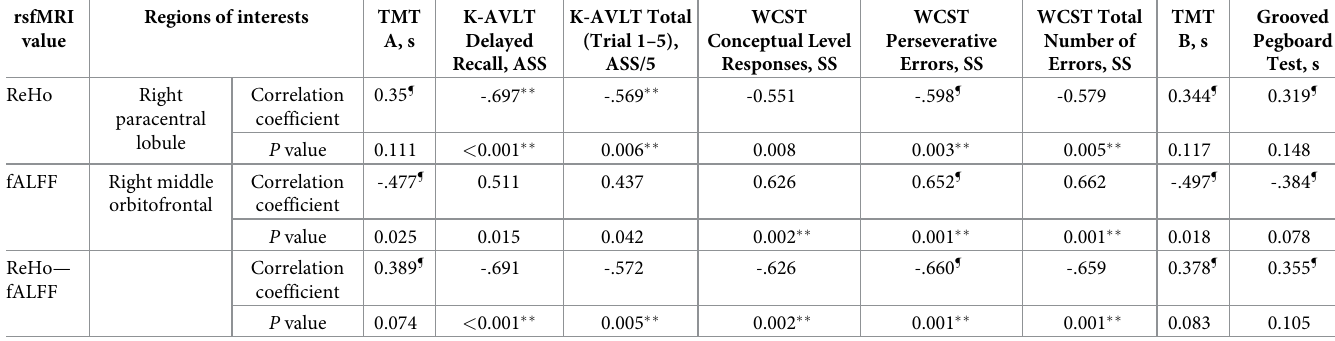
Table 3. Correlation analysis of selected ROIs and cognitive function